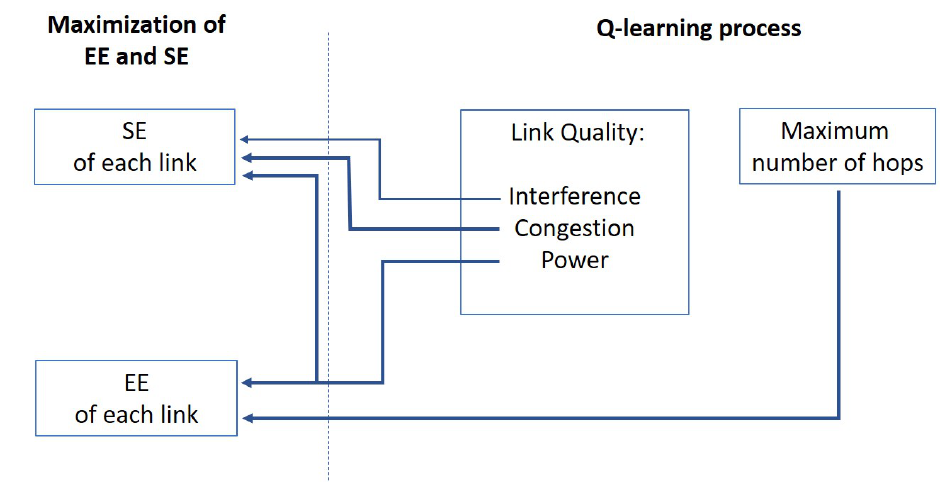
Figure 2. Rationale of the Q-learning process for the maximization of energy and spectral efficiencies